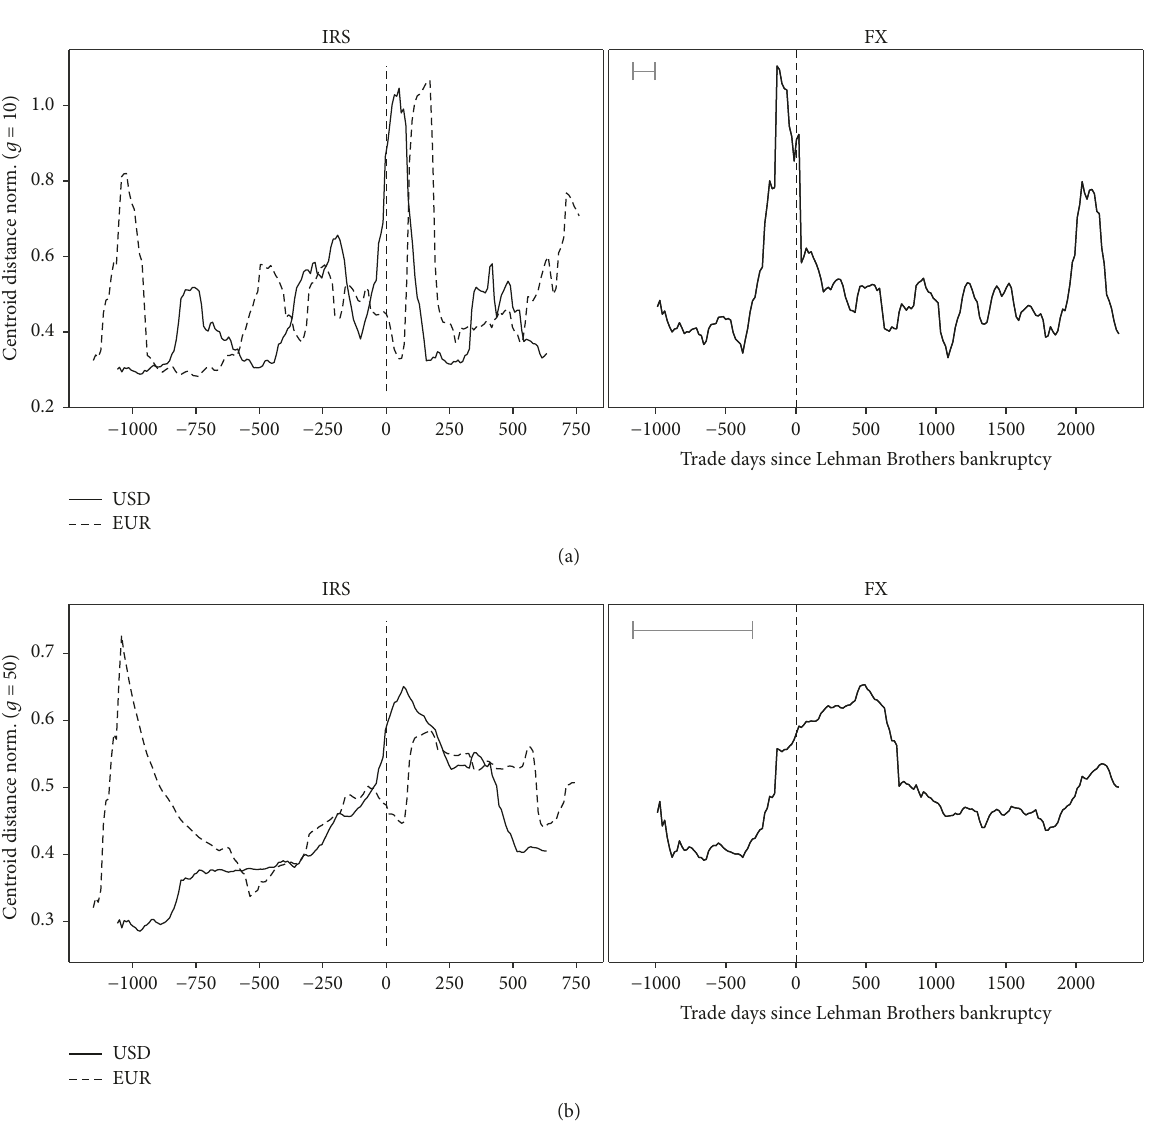
Figure 6: The proposed instability indicator (12) calculated for all three datasets. (a) is for small sliding window size ( 𝑔 = 10 ) and (b) for a long sliding window size ( 𝑔 = 50 ), showing the indicator both on short and long time scales. The indicator is computed from the sequence of 200 information feature vectors in Figures 4 and 5. The sliding window size ( 𝑔 ) is illustrated by the gray bar in the top left of the right-hand panels. The first 𝑔−1 indicator values are averages of fewer than 𝑔 preceding values. One year corresponds to about 250 trade days. Note that the 𝑥 -axes left and right are different. Δ𝑡 = 10